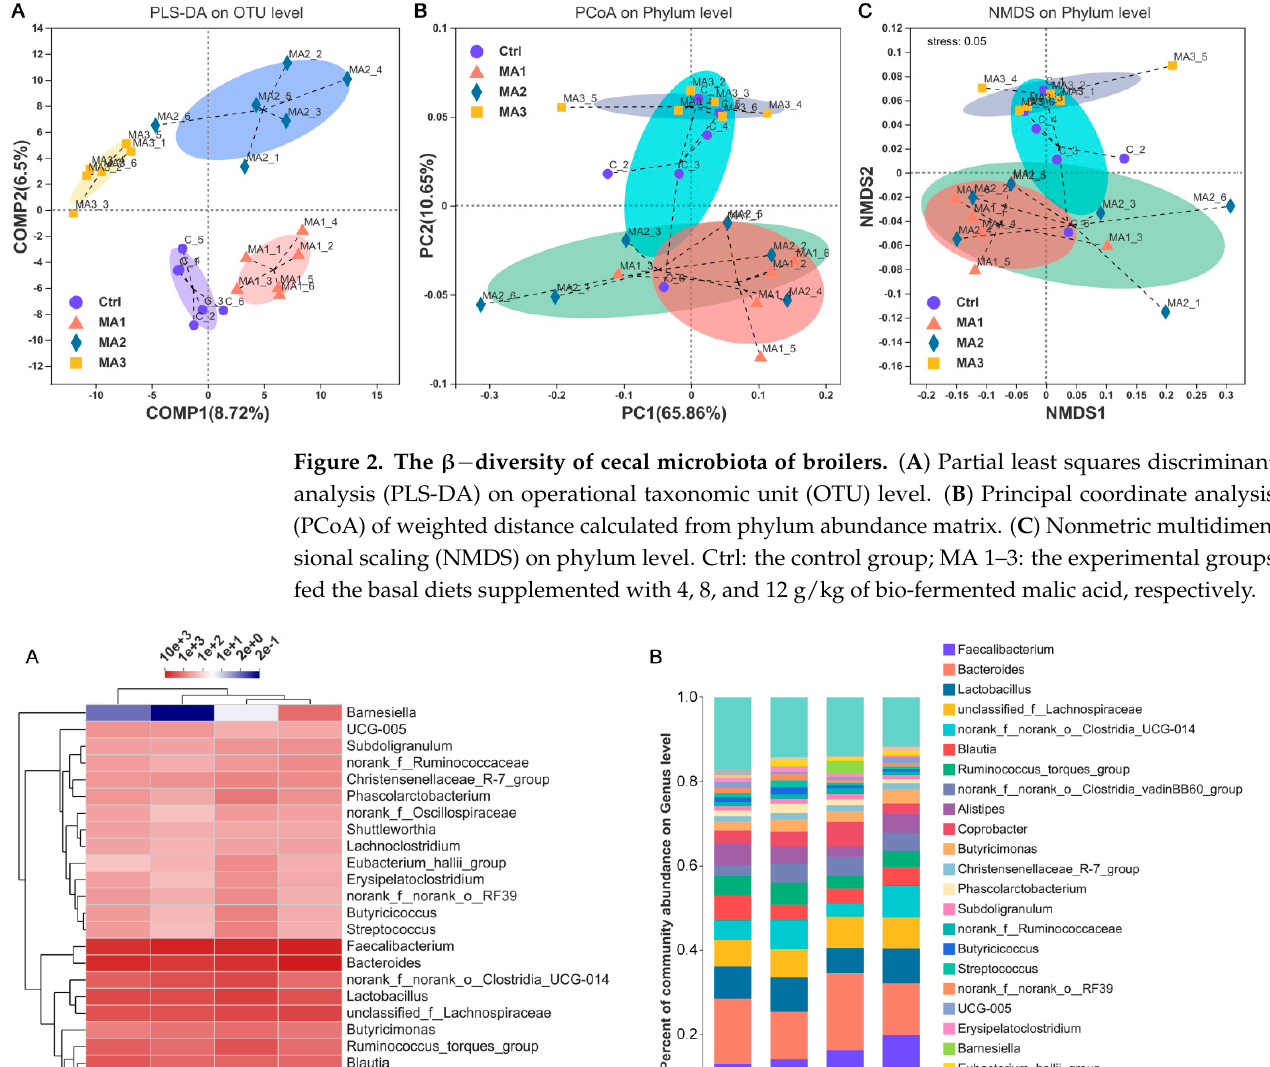
Figure 3. The microbial composition on genus level in cecum of broilers. ( A ) Hierarchical clus- tering of the top 25 genera based on their abundance. ( B ) The genus composition of cecal microbi- ota of broilers. Ctrl: the control group fed the basal diets; MA 1, 2, 3: the experimental groups fed the basal diets supplemented with 4, 8, and 12 g/kg of bio-fermented malic acid, respectively.